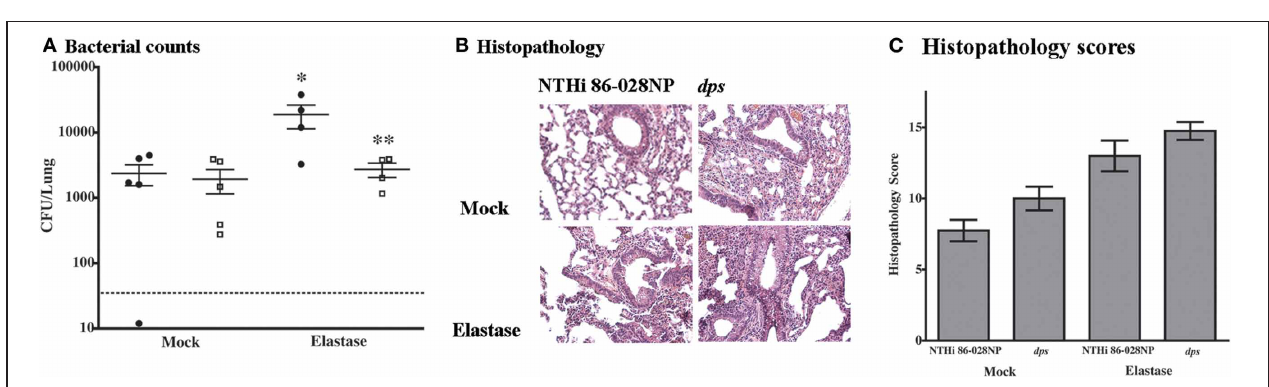
FIGURE 5 | Effect of dps on NTHi resistance to pulmonary clearance. (A) Bacterial counts from lungs of elastase-treated mice (Pang et al., 2008a). Animals were pretreated with elastase as described previously and allowed to recover for 14d prior to infection. Mock-treated animals received vehicle (PBS). Points represent counts derived from individual mice. Error bars represent standard error of the mean. Statistical significance was determined by nonparametric T -test using Welch’s correction.